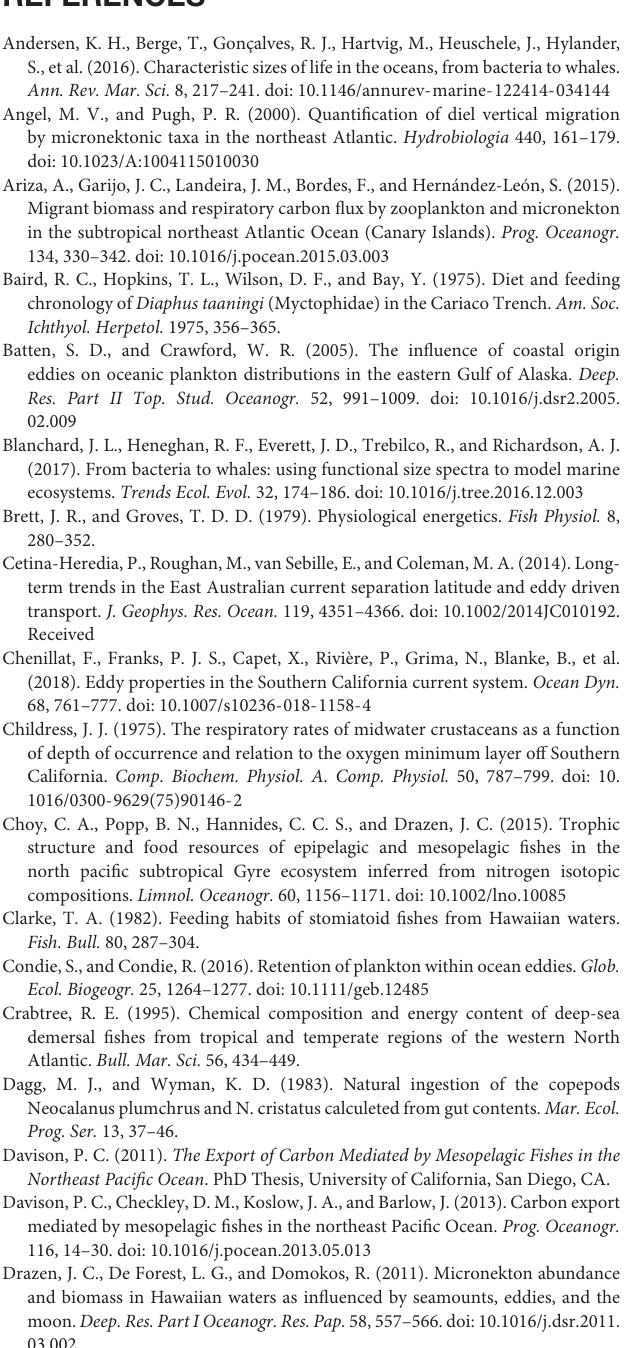
TABLE S6 | Regression equations used to calculate respiratory oxygen uptake (RO; µ L O 2 · ind · − 1 h − 1 ), where DW is individual dry weight (mg), WW is individual wet weight (mg), T is temperature ( ◦ C), and D is depth (m). TABLE S7 | Values of ISF (% of total body weight) and gut passage time (GPT; h) used to calculate active carbon transport. Where values were not available for specific species of fish the average ISF and GPT for mesopelagic fish were applied. Only organisms that were undergoing DVM are included. Where DW = dry weight (mg), CW = carbon weight (mg), T = temperature ( ◦ C), and FP = daily fecal pellet production.